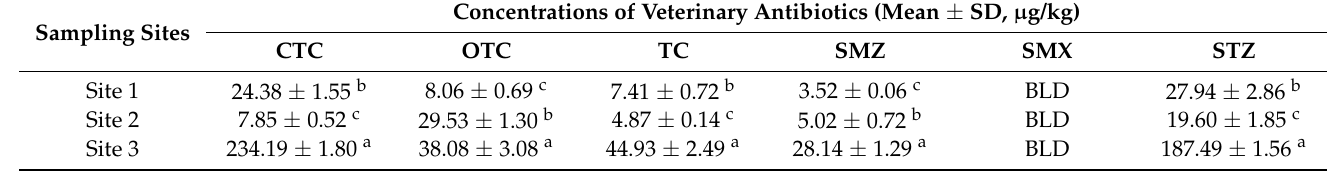
Table 4. Concentrations of veterinary antibiotics in manure-based compost. Sampling Sites